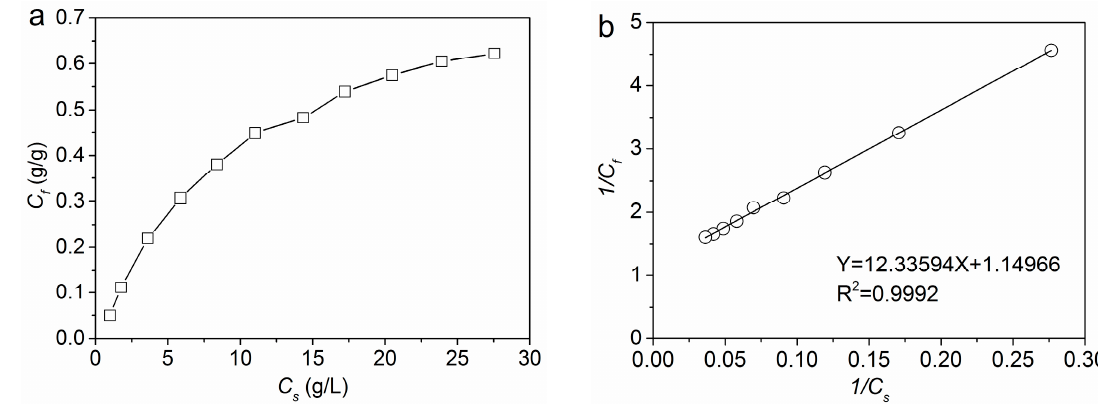
Figure 3. Adsorption isotherm of PA on wool: ( a ) plot of C f vs. C s and ( b ) plot of 1/ C f vs. 1/ C s .